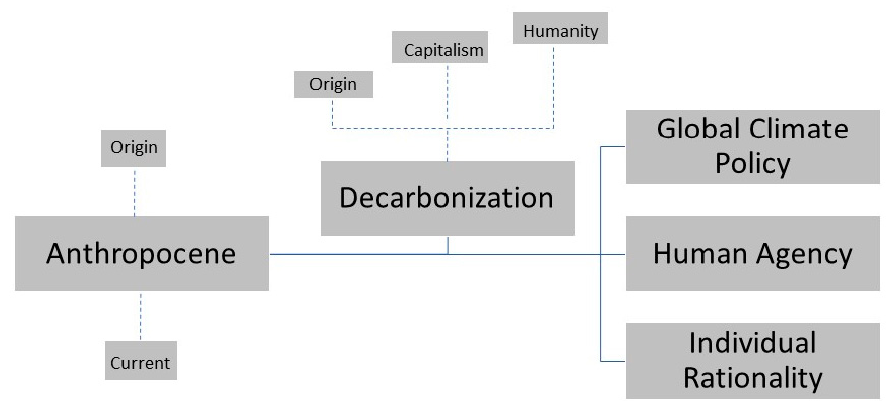
Figure 2. Theoretical model used for the study.